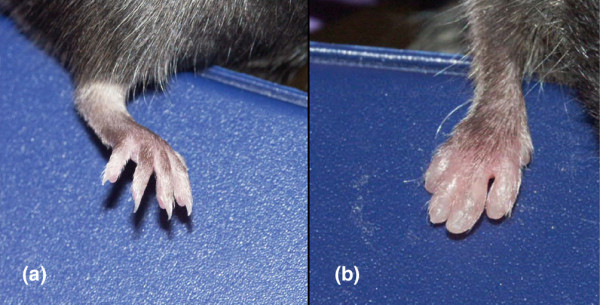
Representative photographs of polyarthritis in DQ6α8β transgenic expressing mice. (a) A normal rear mouse paw and (b) an acute arthritic rear mouse paw, representative of polyarthritis occurring during spontaneous polychondritis.